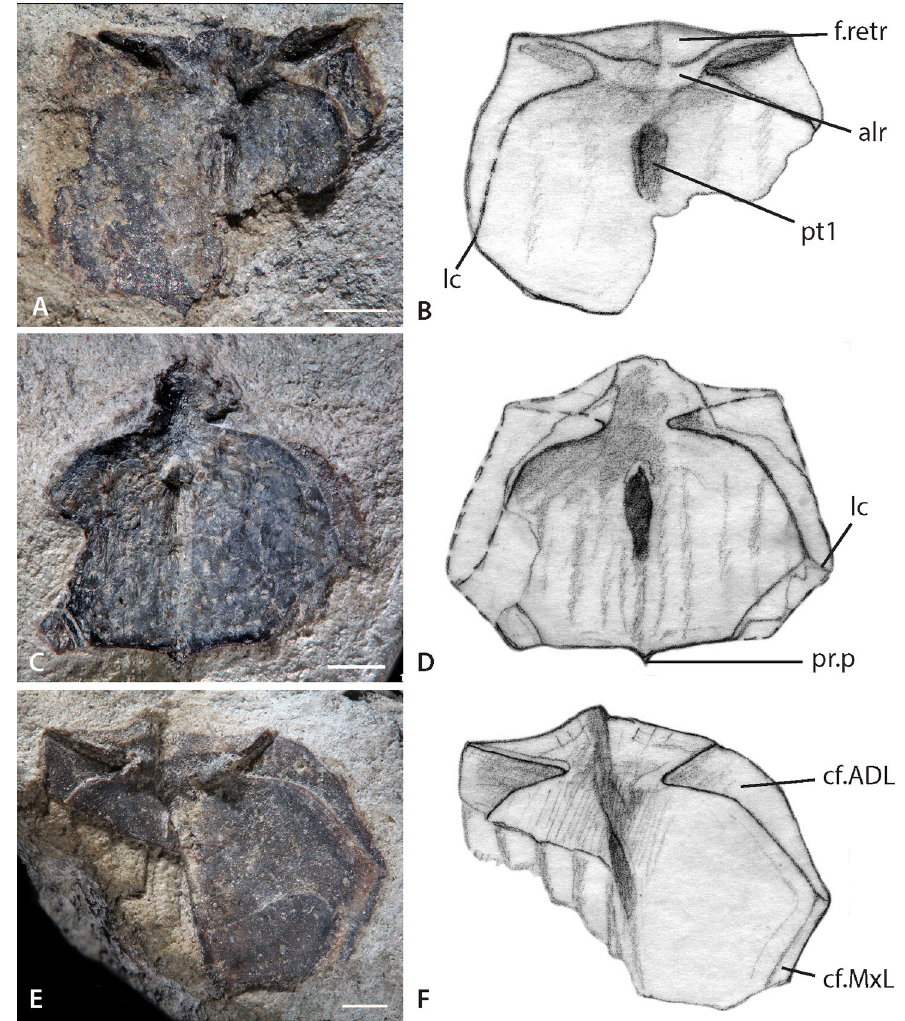
Fig. 5. Microbrachius kedoae specimens from the Gavrilchitsy 45 borehole. Anterior median dorsal plates in visceral view. A , B , GIT 767-4. C , D , GIT 767-5. E , F , GIT 767-6. Scale bars = 1 mm. Abbreviations: ADL, anterior dorso-lateral plate; AMD, anterior median dorsal plate; MxL, mixilateral plate; alr, postlevator thickening of AMD; cf.ADL, area overlapping ADL; cf.MxL, area overlapping MxL; f.retr, levator fossa of AMD; lc, lateral corner of AMD; pr.p, posterior median process of AMD; pt1, anterior ventral pit of dorsal wall of trunk